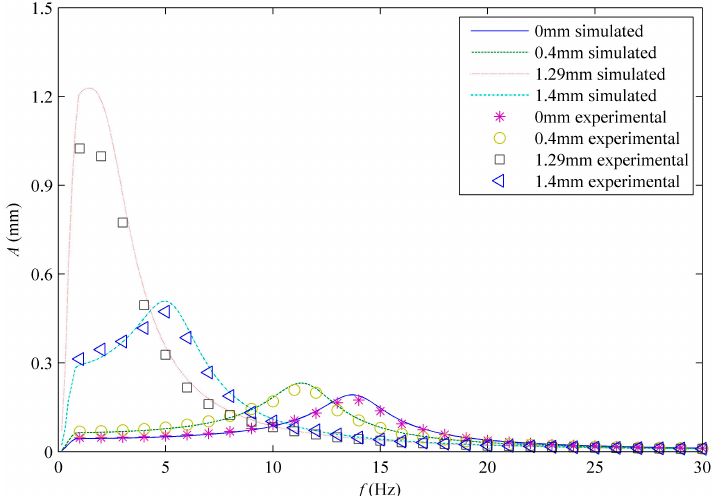
Figure 11. The response measured via laser experiment (points) and simulation (lines) for a stiffness of 10 kN/m and pretensions of Δ l b = 0 mm (asterisks and solid line), 0.4 mm (circles and dashed line), 1.29 mm (triangles and dotted line), and 1.4 mm (squares and dashed-dotted line) over a range of